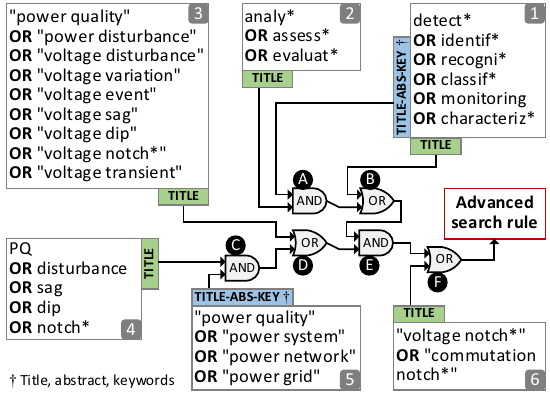
Fig. 3 Advanced search rule applied in the Scopus